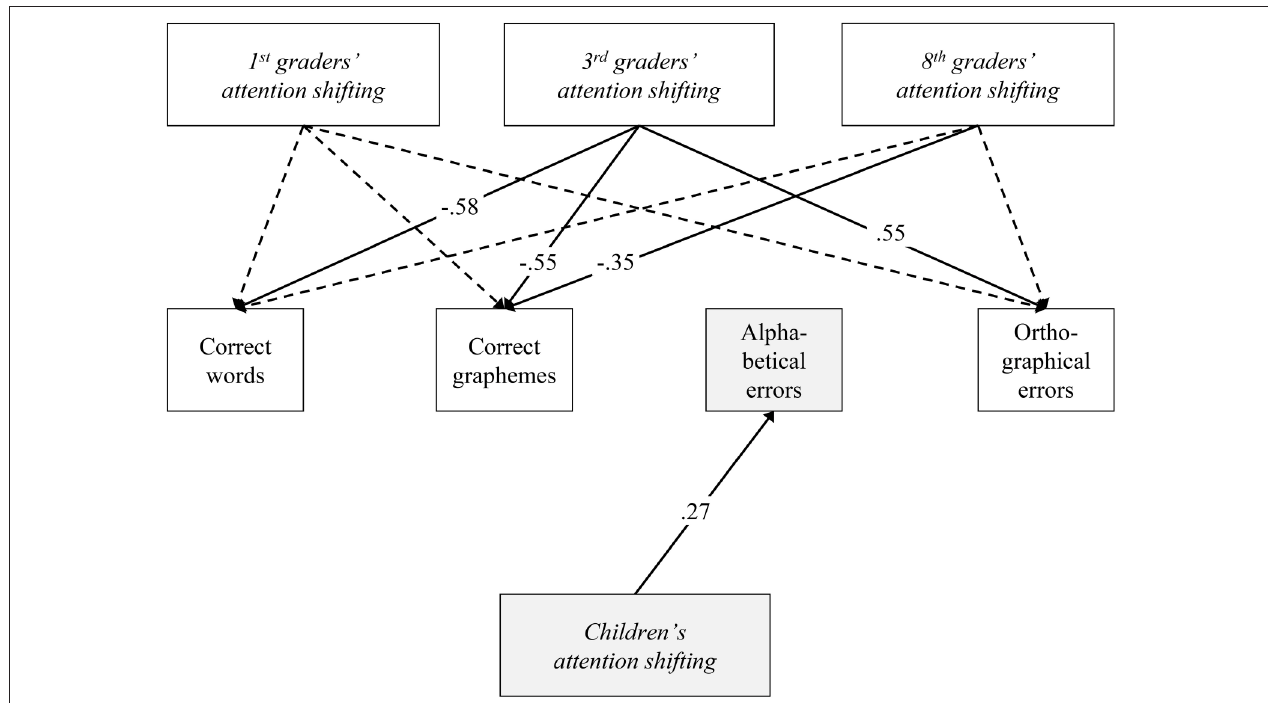
FIGURE 1 | Favored structural partial invariant model regarding age for prediction of orthographic competences. Structural age invariance was tested using Bayes estimation. Analyses control for child age, gender, and migration background. Solid lines indicate meaningful relations (standardized coefficients), each with a Bayesian Credibility Interval excluding zero (see Tables 2, 3 ). Gray boxes highlight age invariant